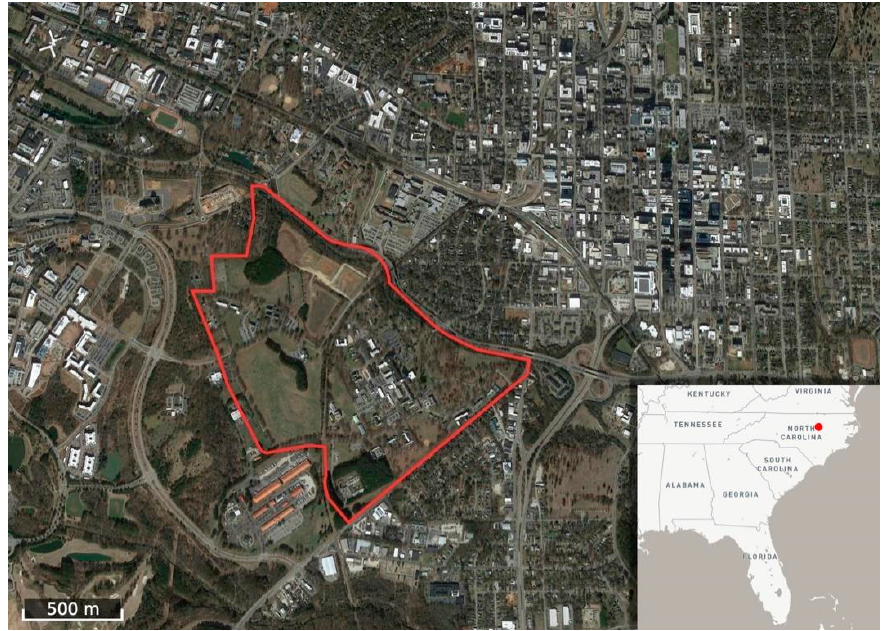
Figure 2. Study area: Dorothea Dix Park.